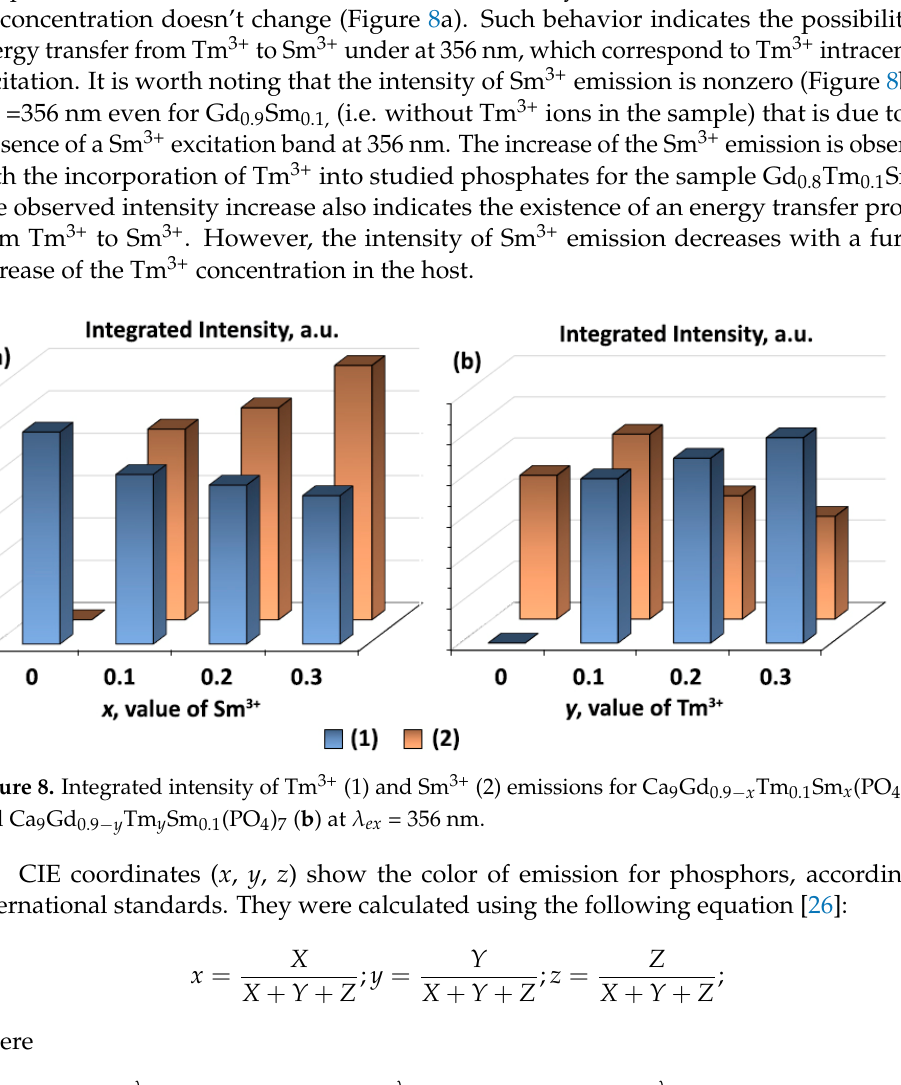
Figure 7. PL spectrum of Ca 9 Gd 0.8 Tm 0.1 Sm 0.1 (PO 4 ) 7 , λ ex = 356 nm.